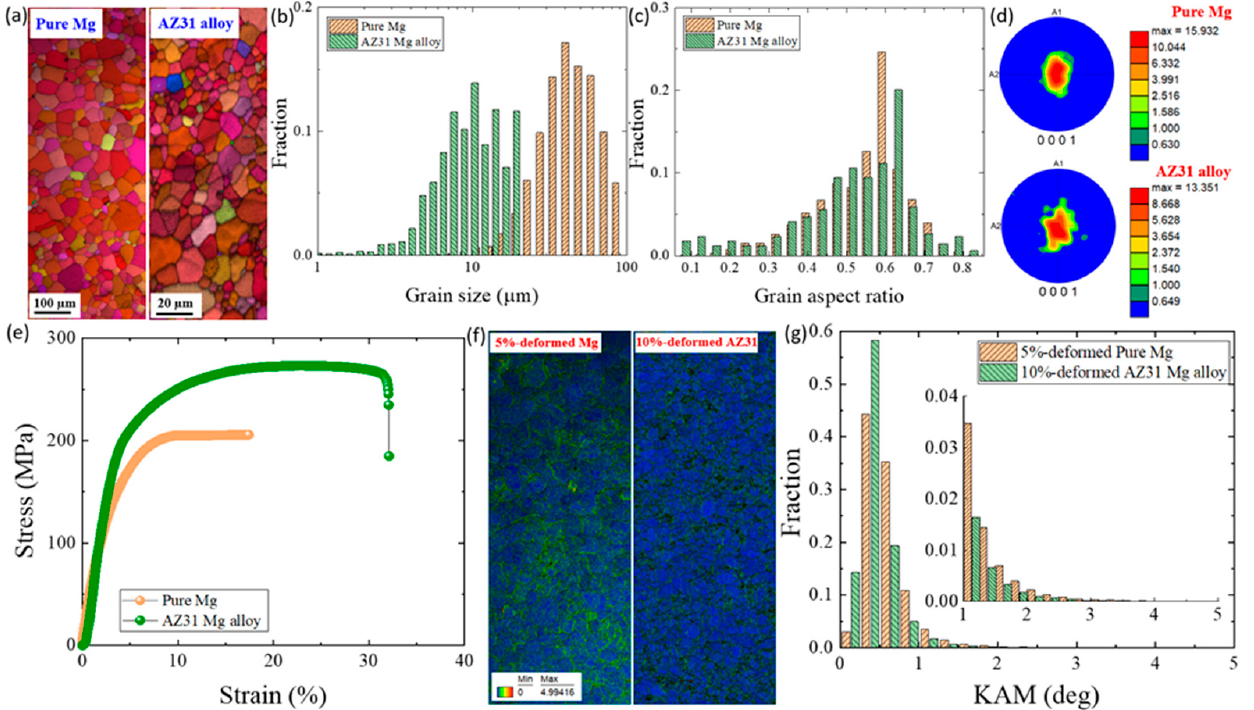
Figure 1. ( a ) Inverse pole figure (IPF) maps, ( b ) grain size distributions, ( c ) grain aspect ratio distribution, and ( d ) pole figures (PF) of the as-received pure Mg and AZ31 Mg alloy, respectively. ( e ) Room temperature tensile curves of the as-received pure Mg and AZ31 Mg alloy. ( f ) Kernel average misorientation (KAM) maps, and ( g ) KAM distributions of the 5%-deformed pure Mg and 10%-deformed AZ31 Mg alloy, respectively. The scale bar interested in the KAM map of the two materials in Figure 1f represents misorientations from 0° to 5° of neighboring points in these maps. The profile in Figure 1g shows the KAMs that are higher than 1° (1–5°).